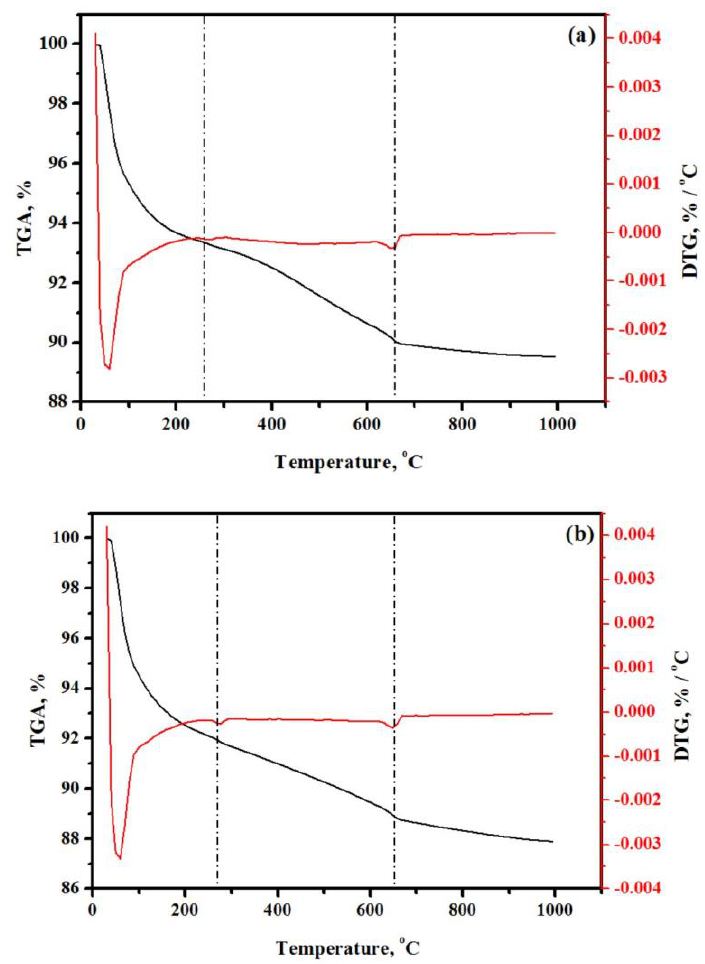
Figure 16. TGA and DTG curves of prepared AAMs with BGWNP at ( a ) 5% and ( b ) 15%.